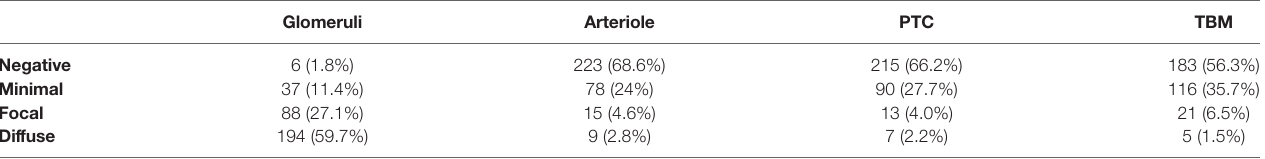
TABLE 2 | C4d staining patterns in different renal anatomic